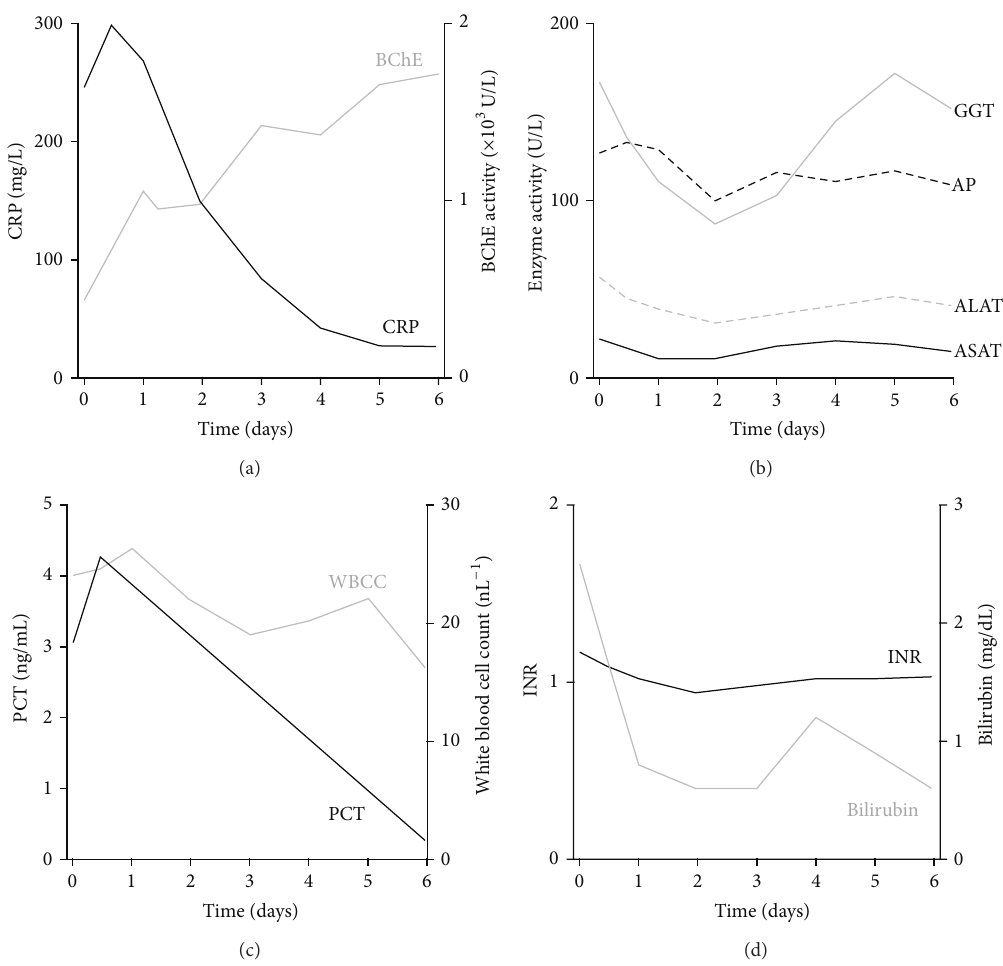
Figure 4: BChE activity mirrors the inflammatory biomarker dynamic change during the course of disease. Diagrams illustrate the course of the systemic inflammation in sixty-five-year-old patient with an abdominal nonhepatic septic focus over the time course of six days. Elevation in the BChE activity matches the drop of the CRP (a) and procalcitonin (PCT (c)) concentration and the fall in the white blood cell count (WBCC (c)). Note that hepatic function tests ASAT, ALAT, GGT, and AP in panel (b) and bilirubin and INR in (d) remained unaltered during the observed time